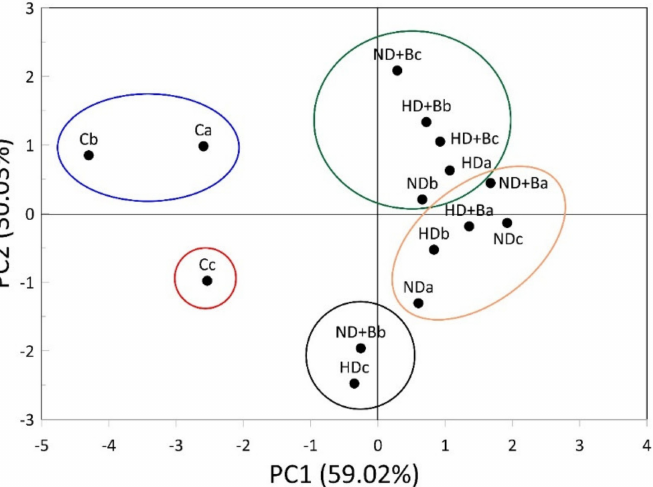
Figure 8. Hierarchical cluster analysis for the measurement of curd yield at the end of the growing season for different N fertilizer treatments with and without biochar. C—control; ND—normal dose; ND+B—normal dose with biochar; HD—high dose; HD+B—high dose with biochar; a-b-c indicate the triplicate